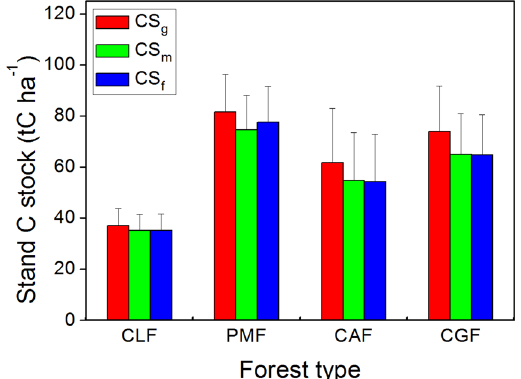
Figure 5. C stock estimates in four forest stands using generic C concentration, C concentrations of tree species and tissues or C concentrations of functional types. The CS g , CS m and CS f refer to the C stocks estimated by using generic C concentration, C concentrations of tree species and tissues, and C concentrations of average value of all tree species in specific functional types, respectively. The CLF, PMF, CAF and CGF represent C. lanceolata plantation (n = 7), coniferous mixed forest (n = 15), deciduous mixed forest (n = 16) and evergreen broadleaved forest (n = 14),